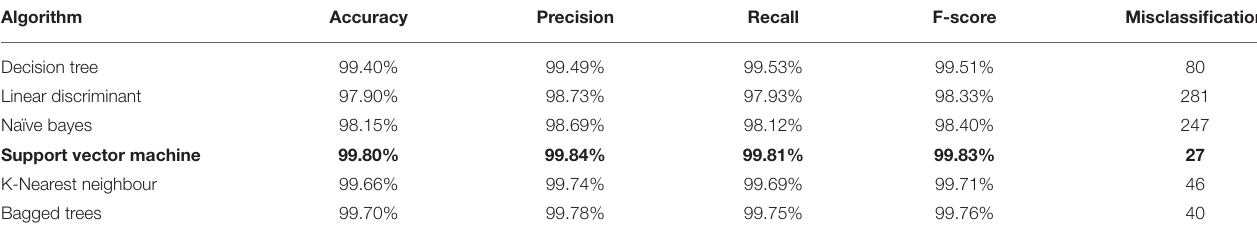
TABLE 12 | Replacement programme performance evaluation.